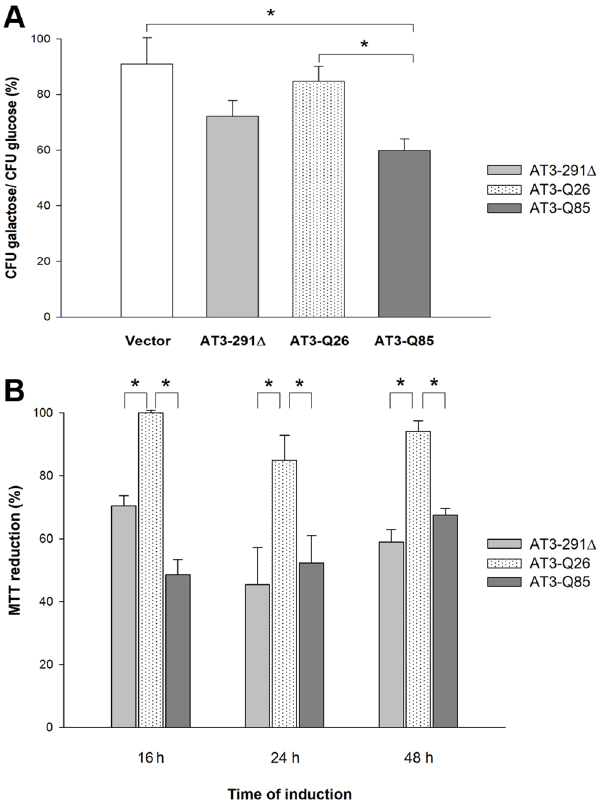
Fig 2. Effect of the AT3 variants expression on cell growth and toxicity. A) Clonogenic assay: about 100 cells from the different cultures were spread onto either glucose or galactose plates and their colony-forming ability expressed as percentage ratio of cells grown under inducing (galactose) versus non-inducing (glucose) conditions. Bars represent standard errors and are derived from at least three independent experiments (P < 0.05). B) MTT assay: the experiment was performed on cultures after the indicated induction times. Data are expressed as percentage ratio of MTT reduction versus the control (empty vector). Bars represent standard errors and are derived from at least three independent experiments (P <